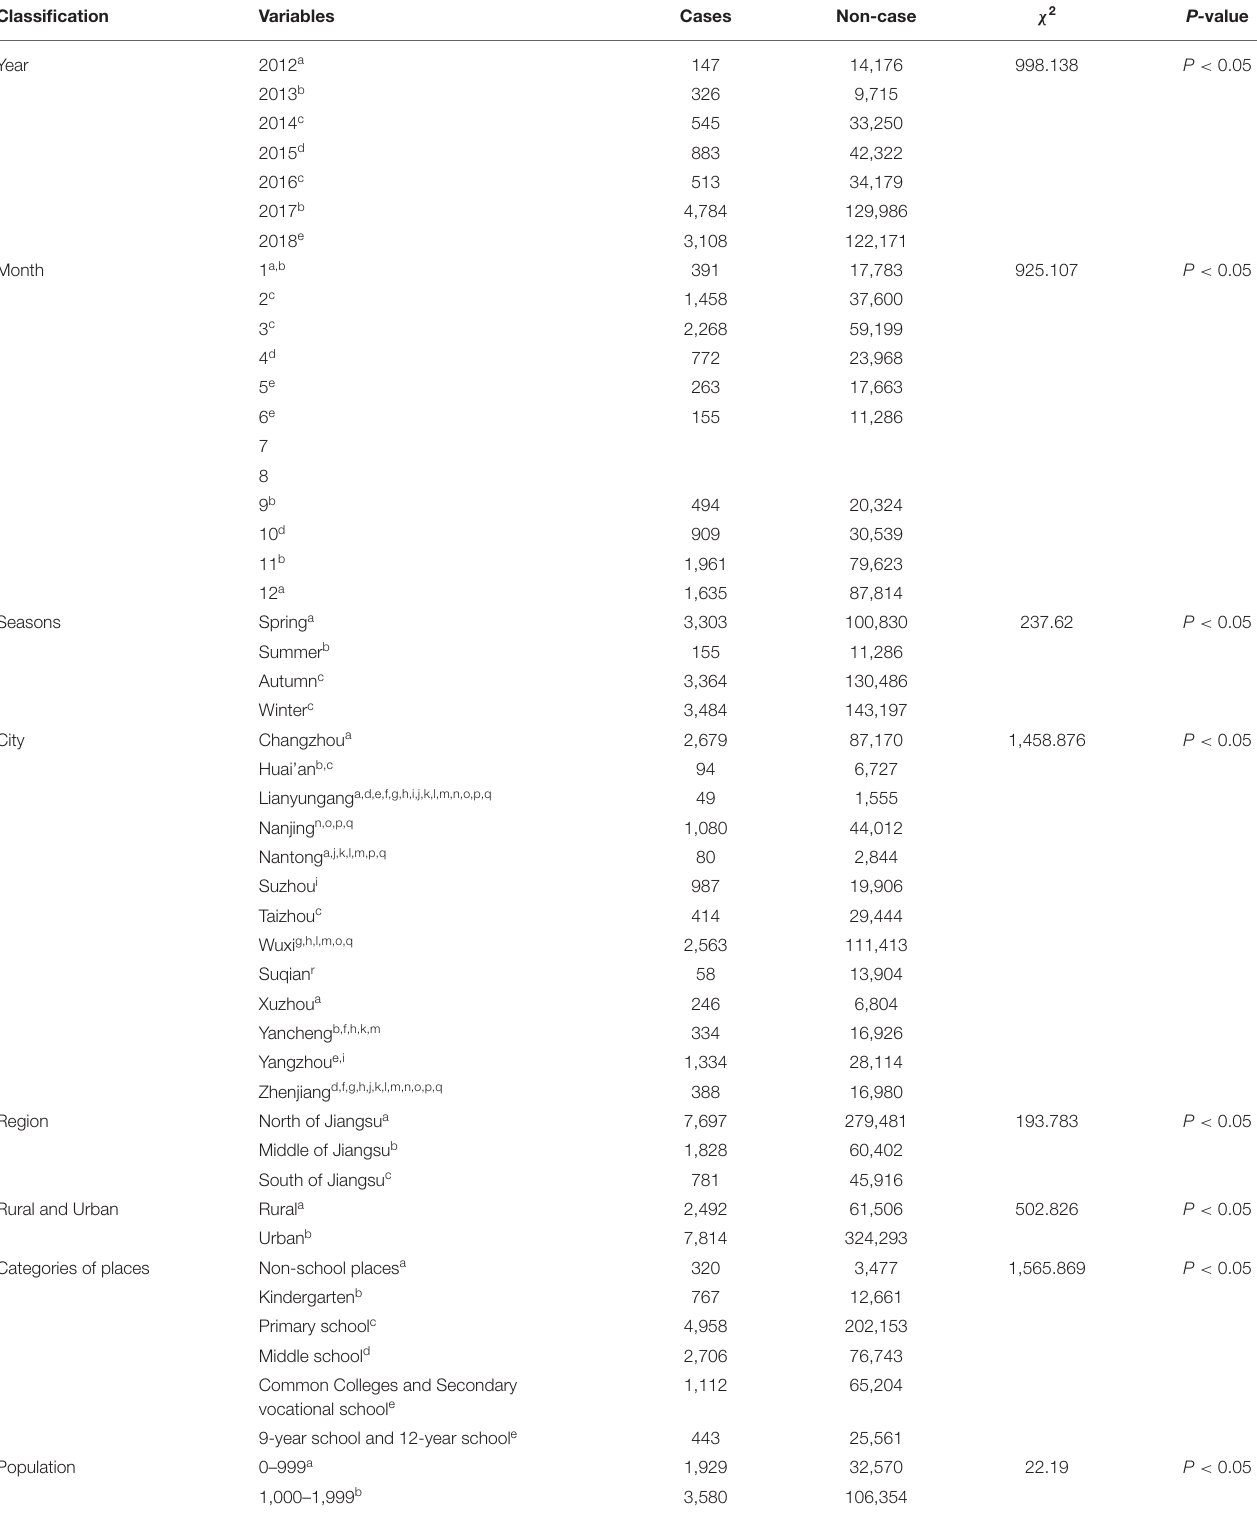
TABLE 3 | Chi-square test and pairwise comparison of the differences in TAR of influencing factors. Classification Variables